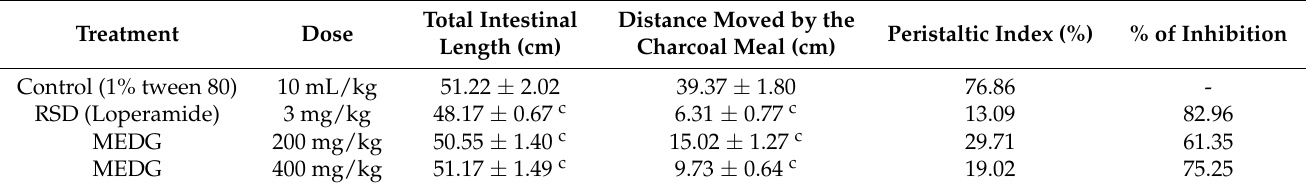
Table 4. Effects of MEDG on charcoal-induced gastrointestinal motility in